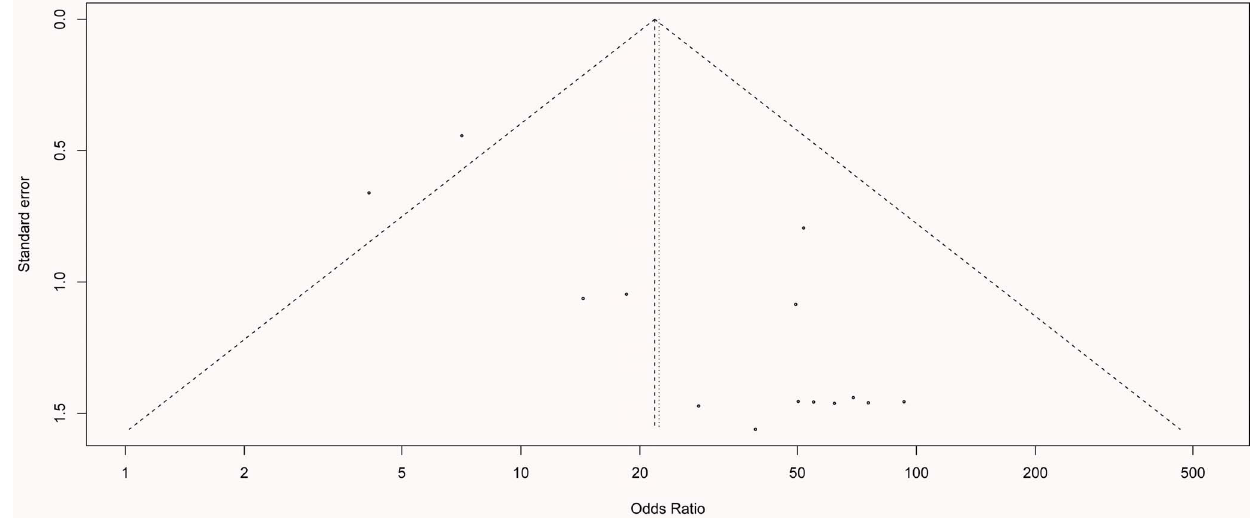
Figure 5. Egger’s funnel plot for assessment of publication bias for the remaining 14 studies in the meta-analysis (each study is represented by a